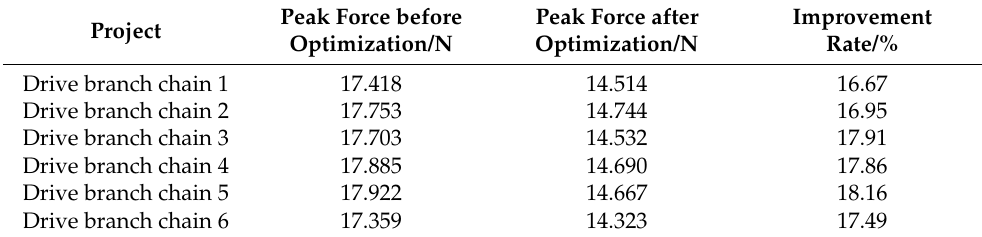
Peak Force after Optimization/N